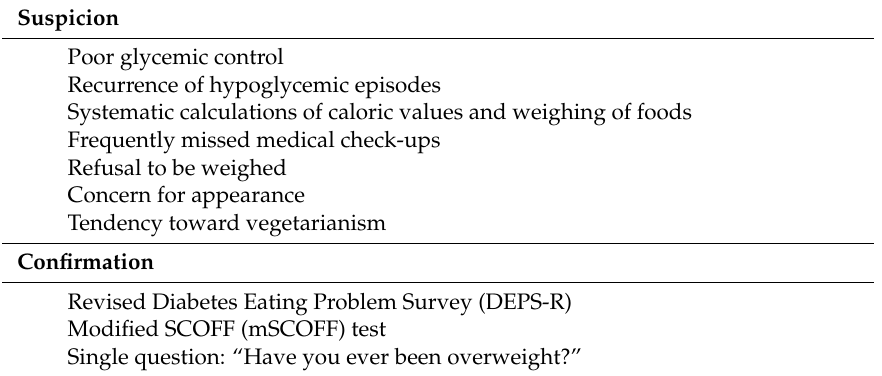
Table 2. Diagnosis of eating disorders (EDs) and disordered eating symptoms (DES) in adolescents with type 1 diabetes